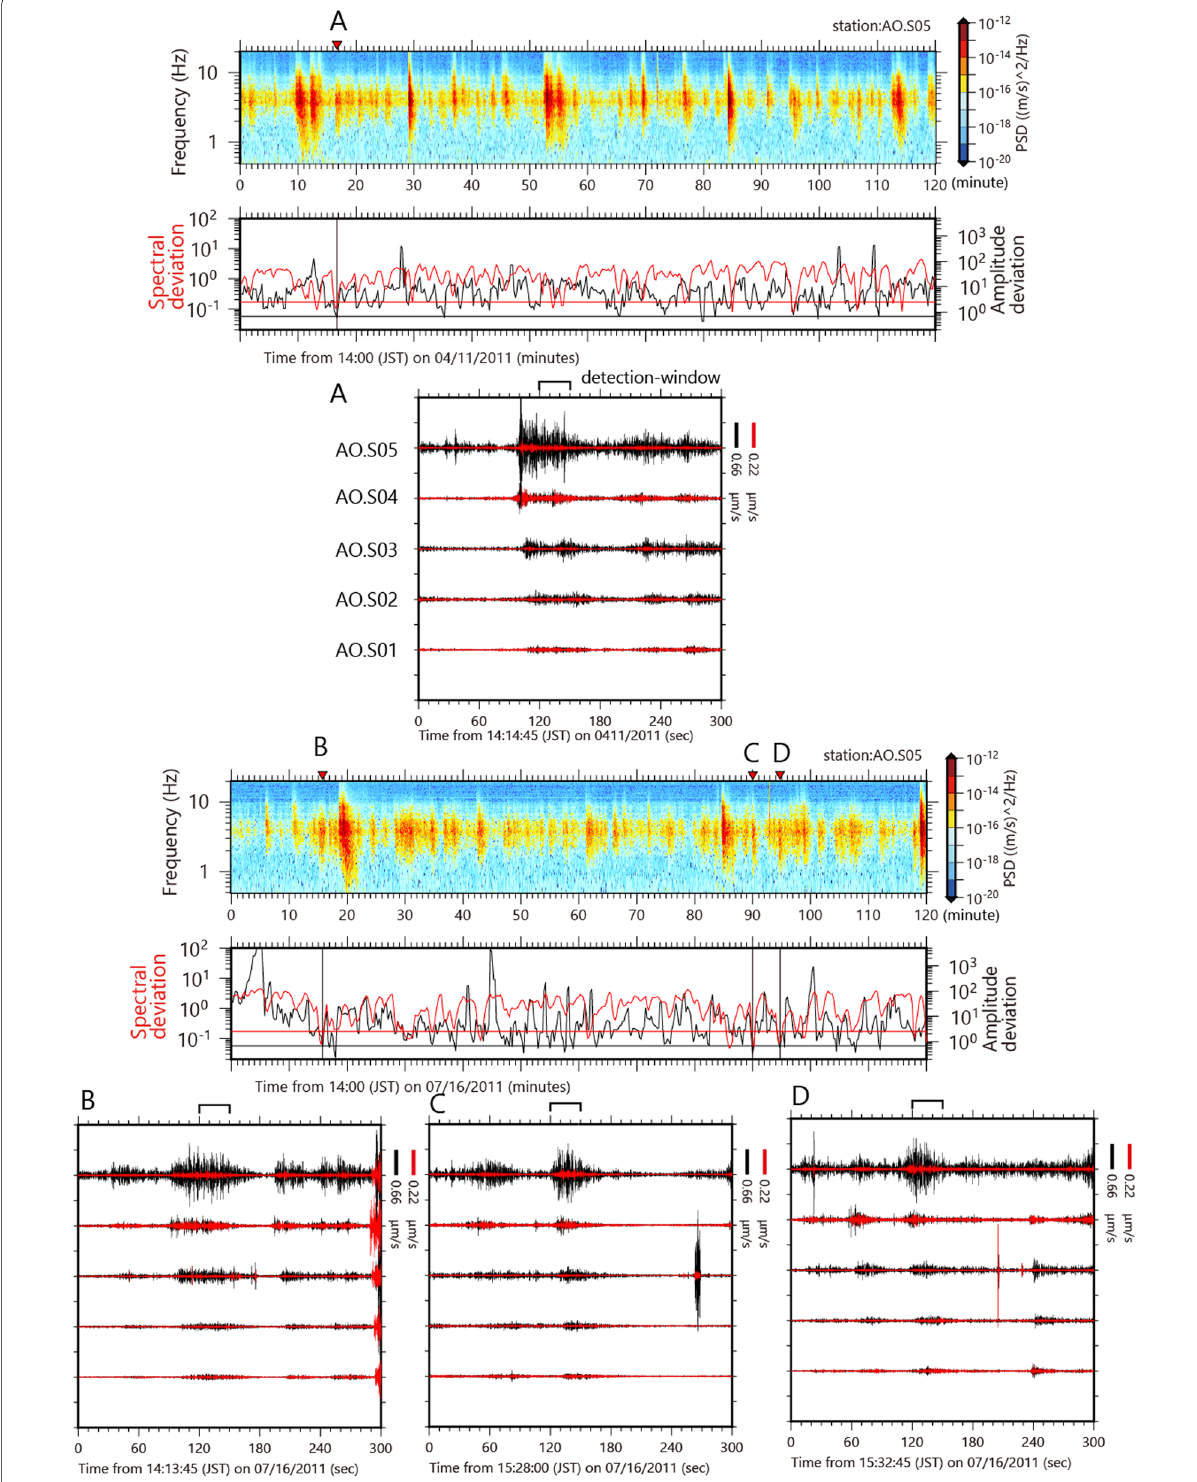
Fig. 8 Examples of newly detected tremors. Two-hour spectrograms of horizontal components, including a tremor (upper) and three tremors (lower) are shown with temporal variations in amplitude and spectral deviations . Red inverted triangles at the top of the spectrograms represent the detection times of the tremors and seismograms of corresponding